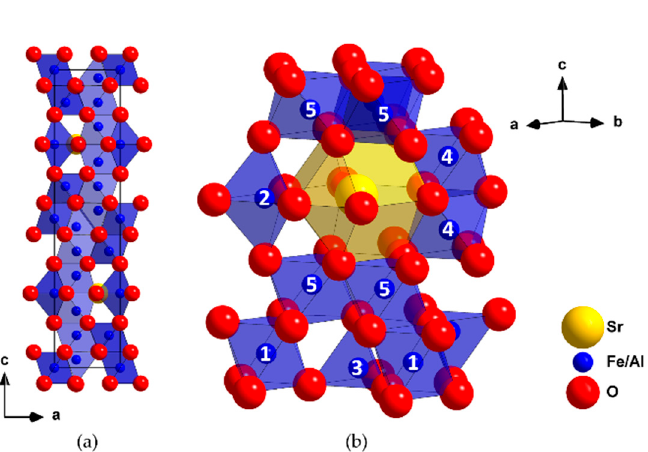
Figure 3. ( a ) Unit cell of the product with magnetoplumbite structure, viewed along [010] with polyhedra around M ; ( b ) A section of the hexagonal structure where iron sites are labelled with numbers 1 ( M (1), octahedrally coordinated), 2 ( M (2), trigonal bipyramidally coordinated), 3 ( M (3), tetrahedrally coordinated), 4 and 5 ( M (4), M (5), octahedrally coordinated) and are mixed occupied by both iron and aluminum in different ratios.